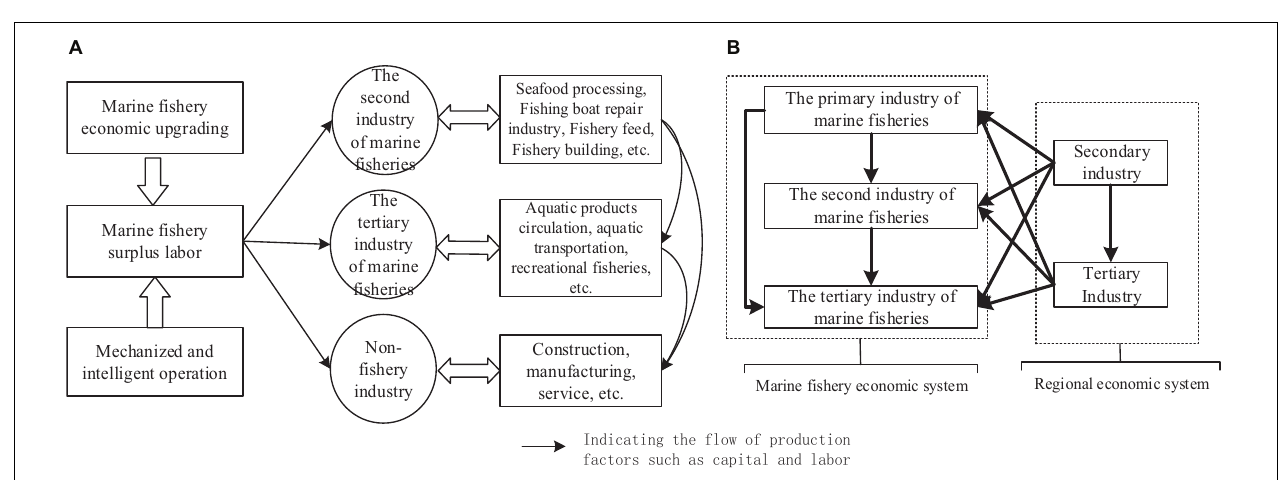
FIGURE 2 | The path of TL affects the economic growth of marine fisheries. (A) Surplus labor flowed to other industries. (B) High-quality production factors returned to the fishery system.